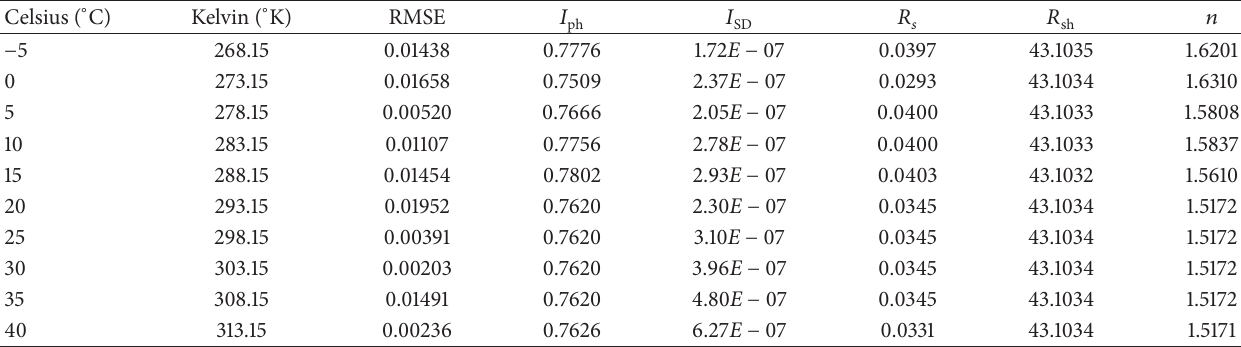
Table 4: Sensitivity analysis of ambient